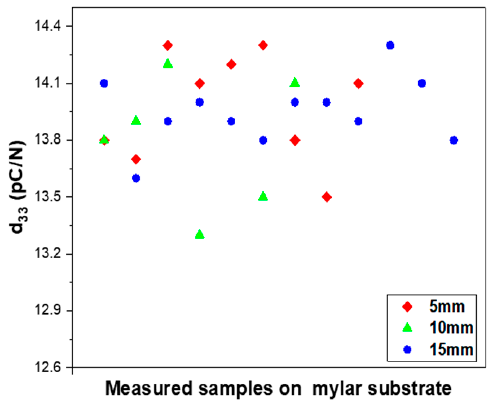
Figure 6. Distribution of the piezoelectric charge coefficient d 33 of the PZT–PVB composites poled at 150 °C on the mylar substrate with various diameters of the electrodes.